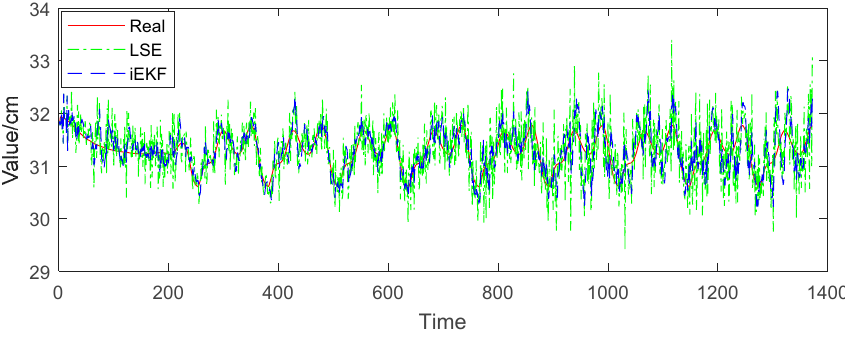
Figure 7. Norm comparison of vector I heart - to - lshoulder .